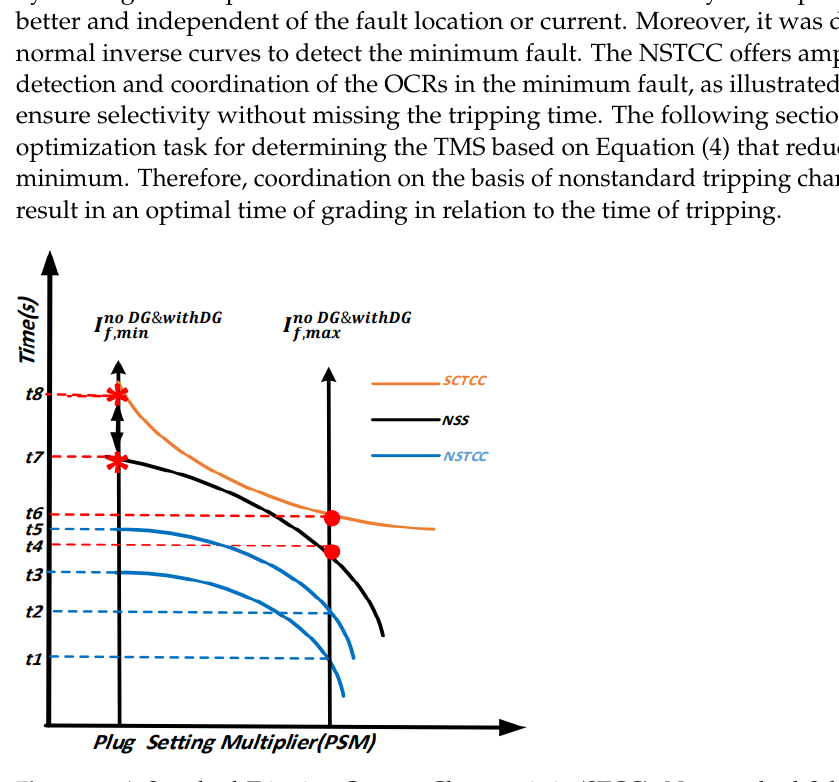
Figure 4. A Standard Tripping Current Characteristic (STCC), Nonstandard Scheme (NSS) and Proposed Nonstandard Tripping Current Characteristic (NSTCC).